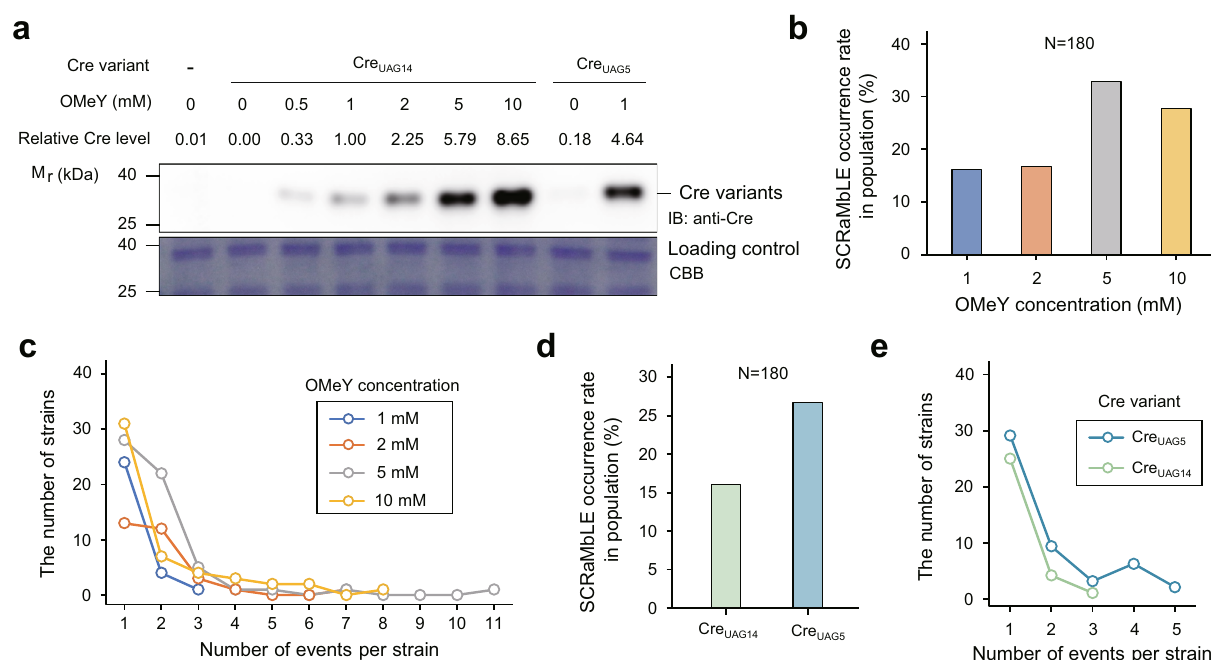
Fig. 3 | The effect of Cre enzyme concentrations on SCRaMbLE outcomes. a Cellularabundance ofCre UAG5 and Cre UAG14 inyeastcellscultured inthe medium with varying concentrations of OMeY (0, 0.5, 1, 2, 5, and 10mM) was measured by western blot using an anti-Cre antibody. Relative abundances of Cre UAG5 and Cre UAG14 are indicated above the gel, and the cellular concentration of Cre UAG14 producedby1mMOMeYisde fi nedas1.00forcomparison.Datawerequanti fi edby ImageJ (version 1.53e). Equal loading was con fi rmed by Coomassie brilliant blue (CBB) staining of parallel gels. Experiments were performed in triplicate, and representative images are shown. b – e The comparison of SCRaMbLE occurrence ratewithinapost-SCRaMbLEyeastpopulation( b and d )andthenumberofalltypes